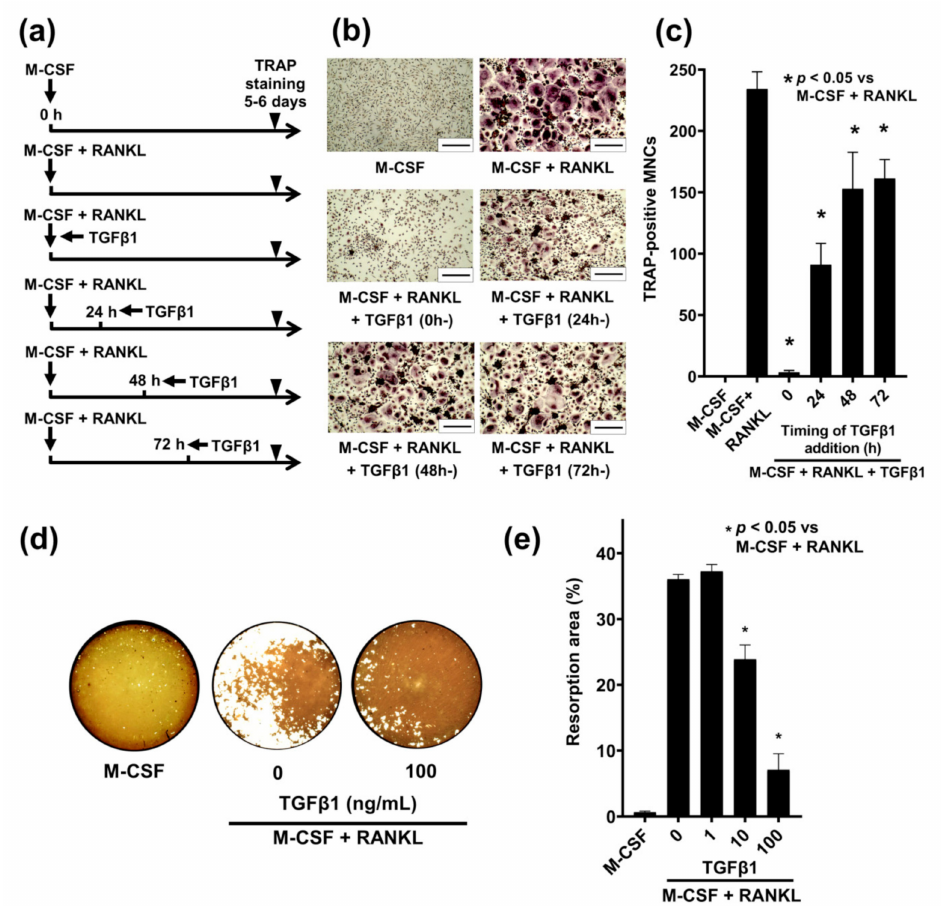
Figure 2. Time-dependent inhibition of osteoclastogenesis and inhibition of bone resorption by TGF β 1 in humans. ( a ) TGF β 1 (100 ng / mL) was added to the peripheral blood monocyte (PBM) culture system at 0, 24, 48, and 72 h after baseline. ( b,c ) The cells were analyzed by tartrate-resistant acid phosphatase (TRAP) staining. The number of TRAP-positive multinucleated cell (MNCs) at the timing of TGF β 1 addition was subtracted from those at the end of the culture period, to normalize the number of MNCs and evaluate the net e ff ect of TGF β 1 on the number of MNCs. Addition of TGF β 1 at 0 and 24 h potently inhibited RANKL-induced osteoclastogenesis. ( d ) Bone resorption activity was analyzed, using Osteo assay plates. PBMs were cultured with M-CSF (50 ng / mL) and RANKL (100 ng / mL) with or without TGF β 1 (100 ng / mL) on Osteo assay surface 96-well plates for 7–12 days, followed by cell lysis and silver nitrate staining. ( e ) TGF β 1 inhibited RANKL-mediated bone resorption activity in a dose-dependent manner. TGF β 1 at concentration ≥ 10 ng / mL significantly suppressed the RANKL-mediated bone resorption activity. * p < 0.05 versus M-CSF + RANKL. During the culture, half the culture medium was replaced with fresh medium containing cytokines and TGF β 1 every three days. Representative microphotographs are shown. Scale bar = 50 µ m. The data are presented as the mean ± standard